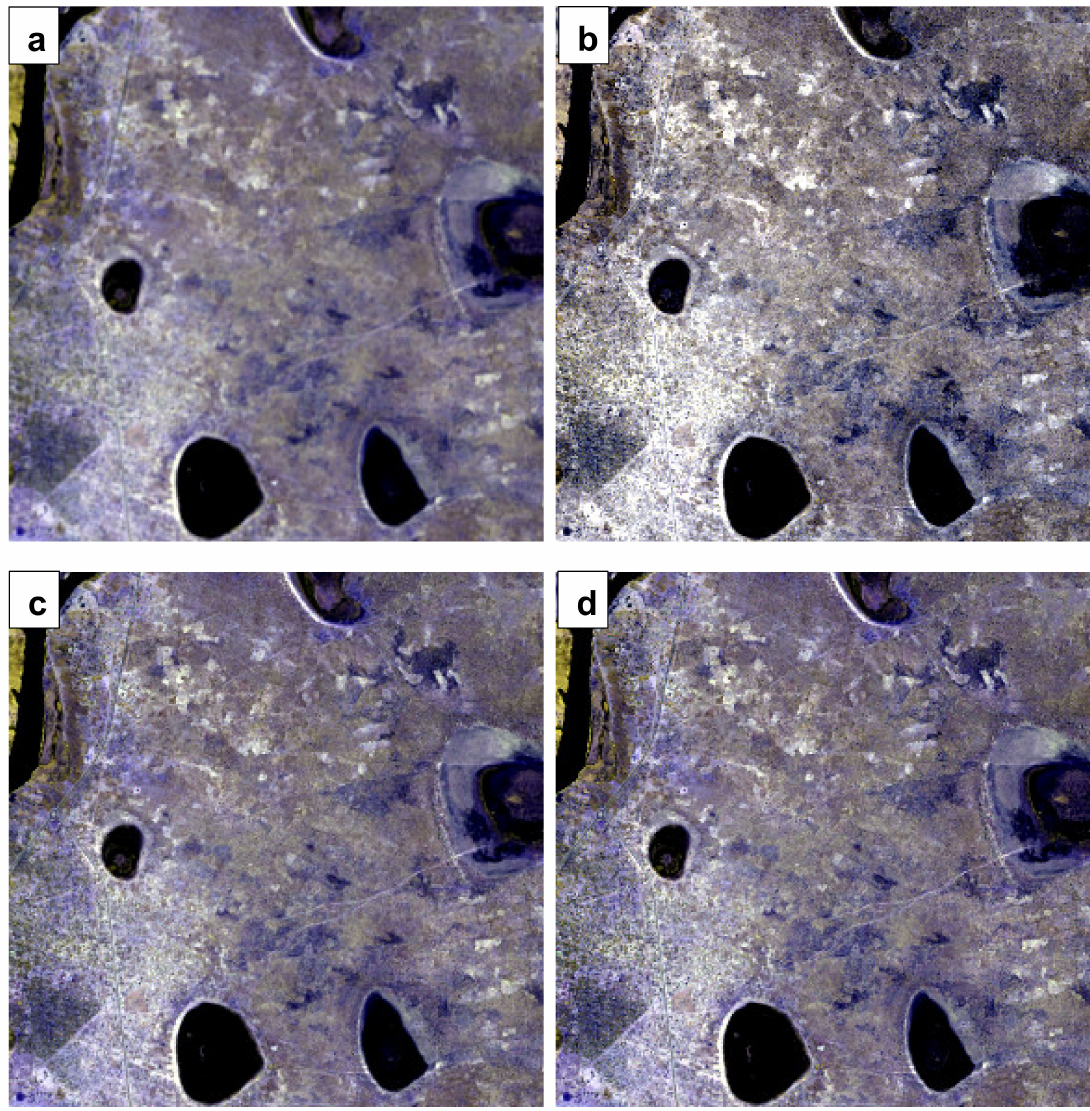
Figure 6. Study site 3 false color surface reflectance images, composed of 1800 × 1800 3.333 m pixels covering 6 × 6 km ( a ) Sentinel-2 NIR (855–875 nm), red-edge (773–793 nm), and SWIR (1565–1655 nm) reflectance bilinear resampled from 20 m, ( b ) Planetscope NIR reflectance and synthetic Sentinel-2 red-edge and SWIR reflectance, ( c ) Sentinel-2 false color reflectance HPM sharpened from 20 m, and ( d ) Sentinel-2 false color reflectance M3 sharpened from 20 m. Images oriented with north at the top of the image. Site and image dates summarized in Table